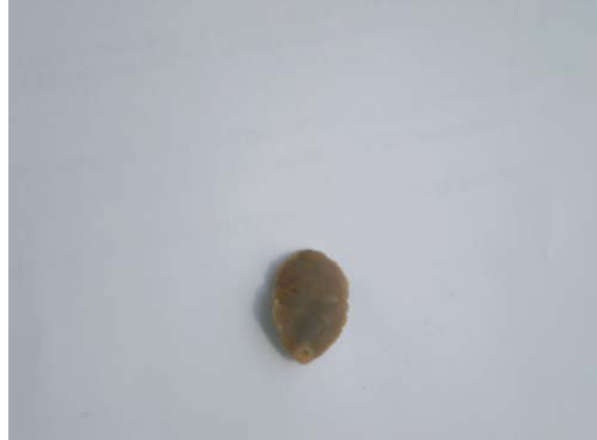
Fig 1 . Adult worm of Fasciolopsis buski